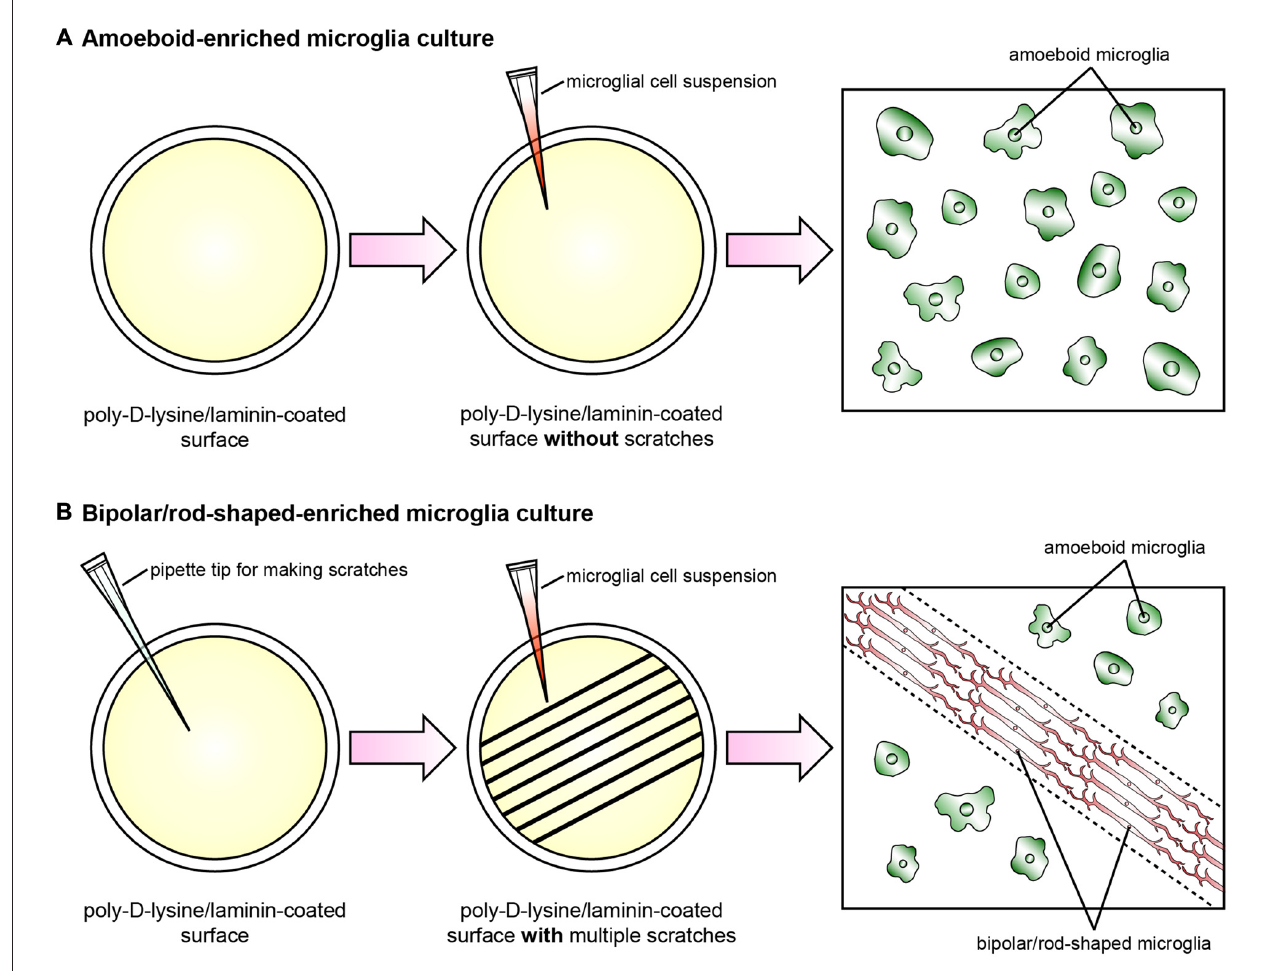
FIGURE 1 | Schematic diagram illustrating the cell culture model systems to enrich amoeboid and bipolar/rod-shaped microglia. Cerebral cortices dissected from postnatal mice were trypsinized and dissociated mechanically, and the cell suspension was plated onto a poly-D-lysine-coated culture flask. The microglia were then isolated from the mixed primary cortical cultures after 10–12 days by gently shaking. The purity of the microglia cultures prepared by this method was >99% (Tam and Ma, 2014; Tam et al., 2016). (A) The vast majority of primary microglia maintained an amoeboid-like morphology after culturing on a poly-D-lysine/laminin-coated surface without any physical scratches. (B) Multiple physical scratches generated by a P200 pipette tip removed the laminin coating, which created laminin-free zones between the non-scratched areas. The primary microglia actively migrated to the scratched area and formed trains of bipolar/rod-shaped microglia (red) in parallel with the direction of the scratches (dotted lines). By contrast, the microglia colonized in the non-scratched surfaces maintained amoeboid morphology (green) while the laminin coating was still